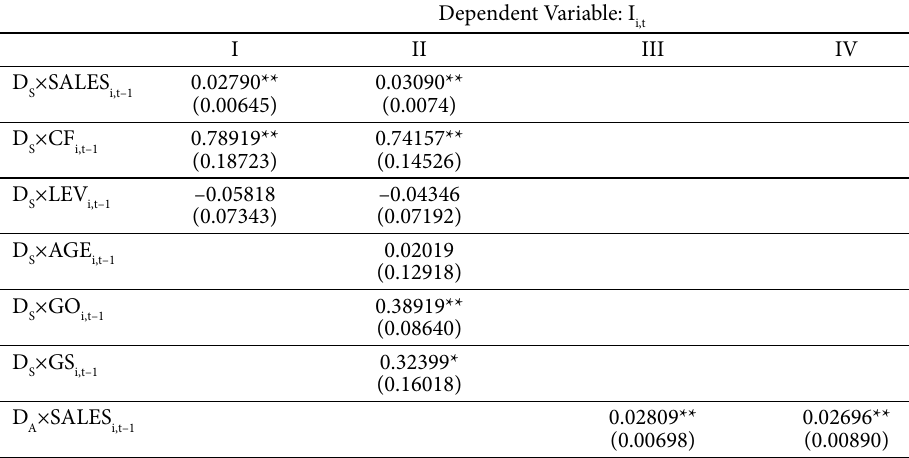
Table 6. investment determinants of fitness